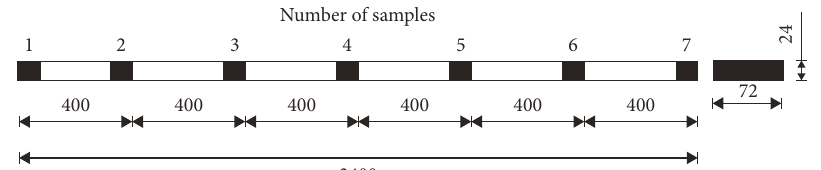
Figure 3: Sample collection.